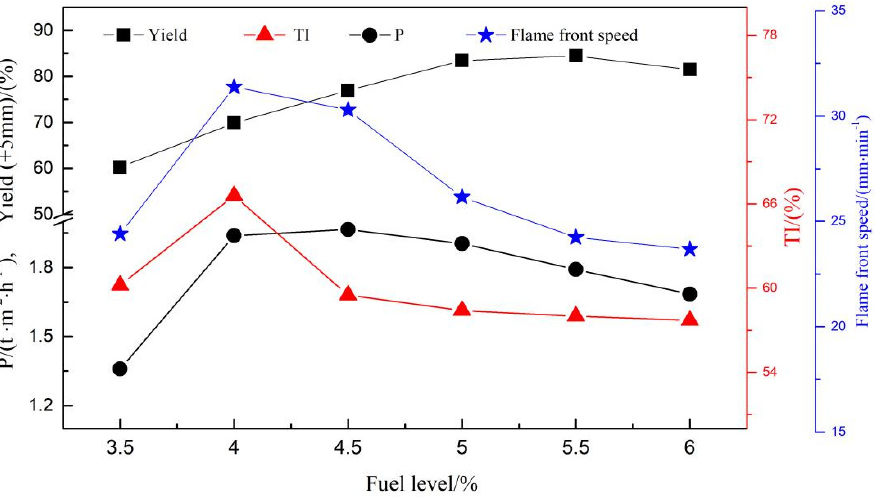
Figure 7. Effect of fuel content on the metallurgical properties and productivity of RVT magnetite sinter.